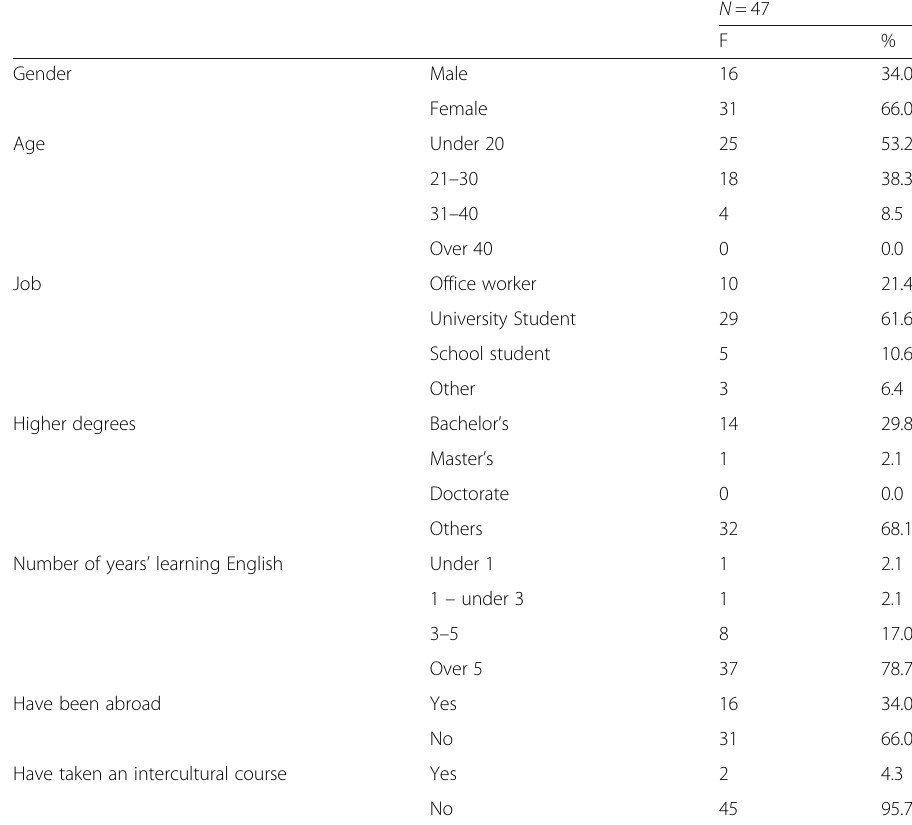
Table 2 Research participants ’ general